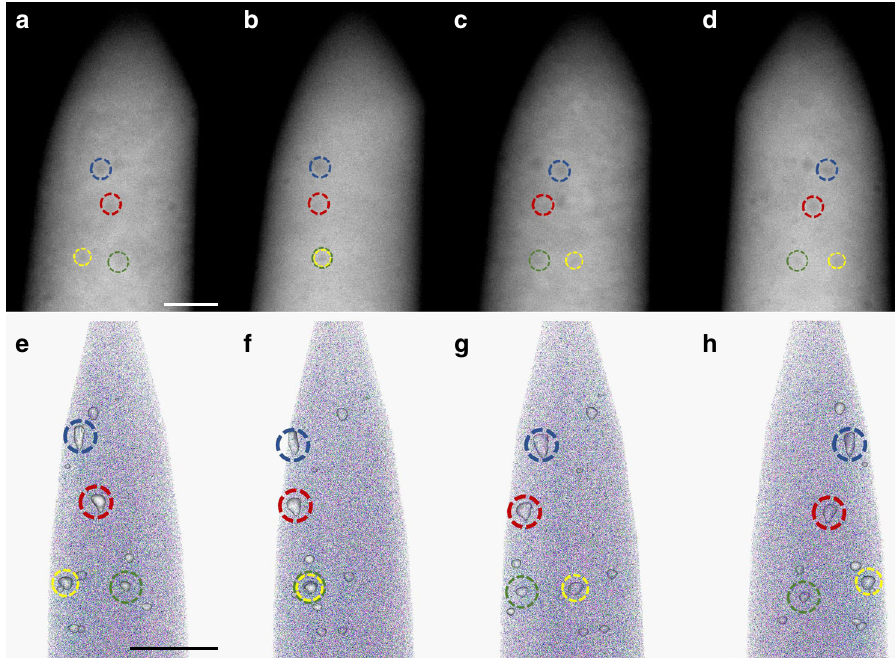
Fig. 1 HAADF-STEM and APT images acquired for a NiCoCr needle-shaped specimen at different rotation angles. STEM and APT images are shown on the top and bottom panels of the fi g., respectively. a and e are at 0°; b and f are at 60°; c and g are at 120°; d and h are at 180°. In the APT reconstructions, 50 atoms/nm 3 iso-density surfaces are shown in white. The same voids are marked by circles of the same color in both the HAADF-STEM image and APT reconstruction. The scale bar for both rows is 40 nm. Note the APT reconstruction only represents the central part of the tip in the HAADF image because only ~60% of the needle is captured in an APT experiment and a focused-ion beam cleaning was performed after the STEM (see Methods for